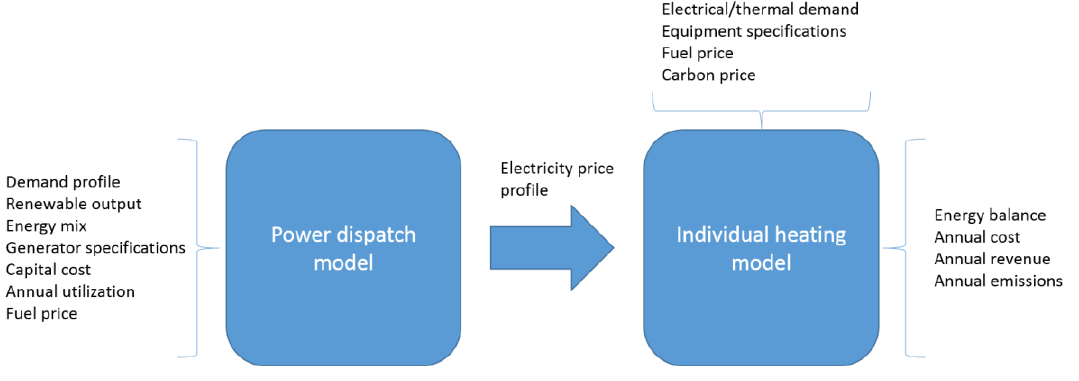
Figure 1. Model description.